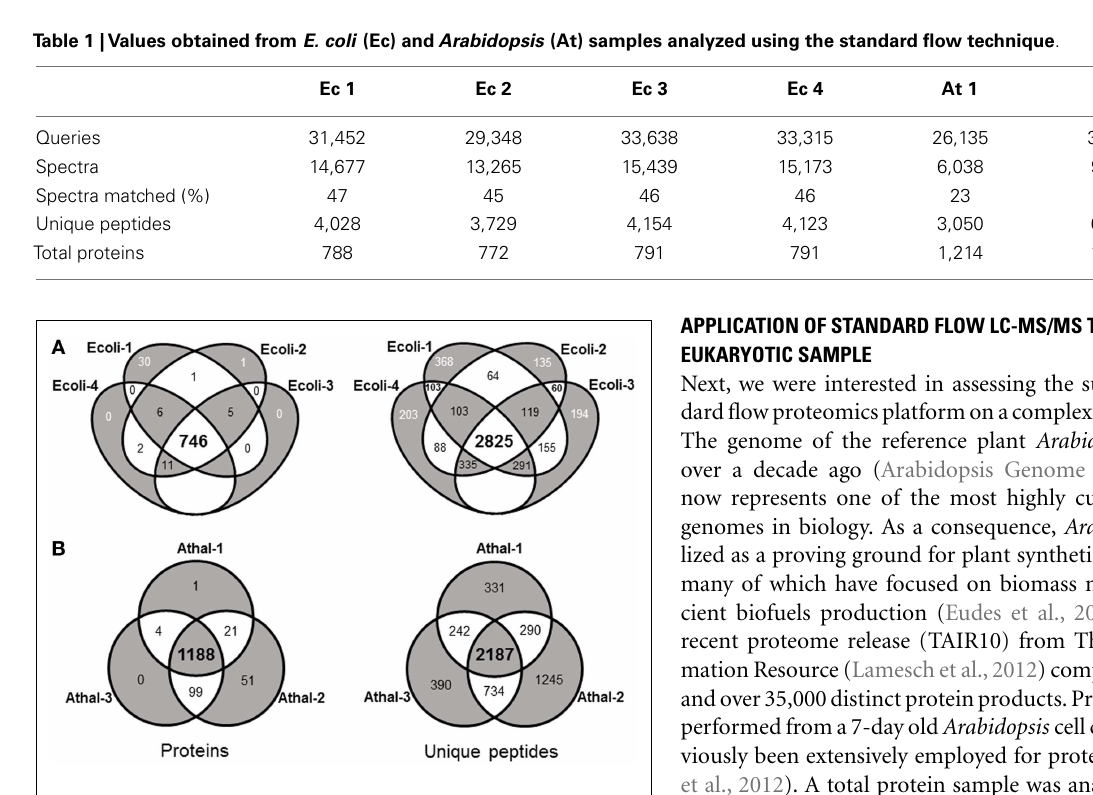
FIGURE 1 |Venn diagrams highlighting the shared matched proteins and unique peptides between technical replicates from (A) E. coli and (B) Arabidopsis total protein samples analyzed with the standard flow LC-MS/MS approach